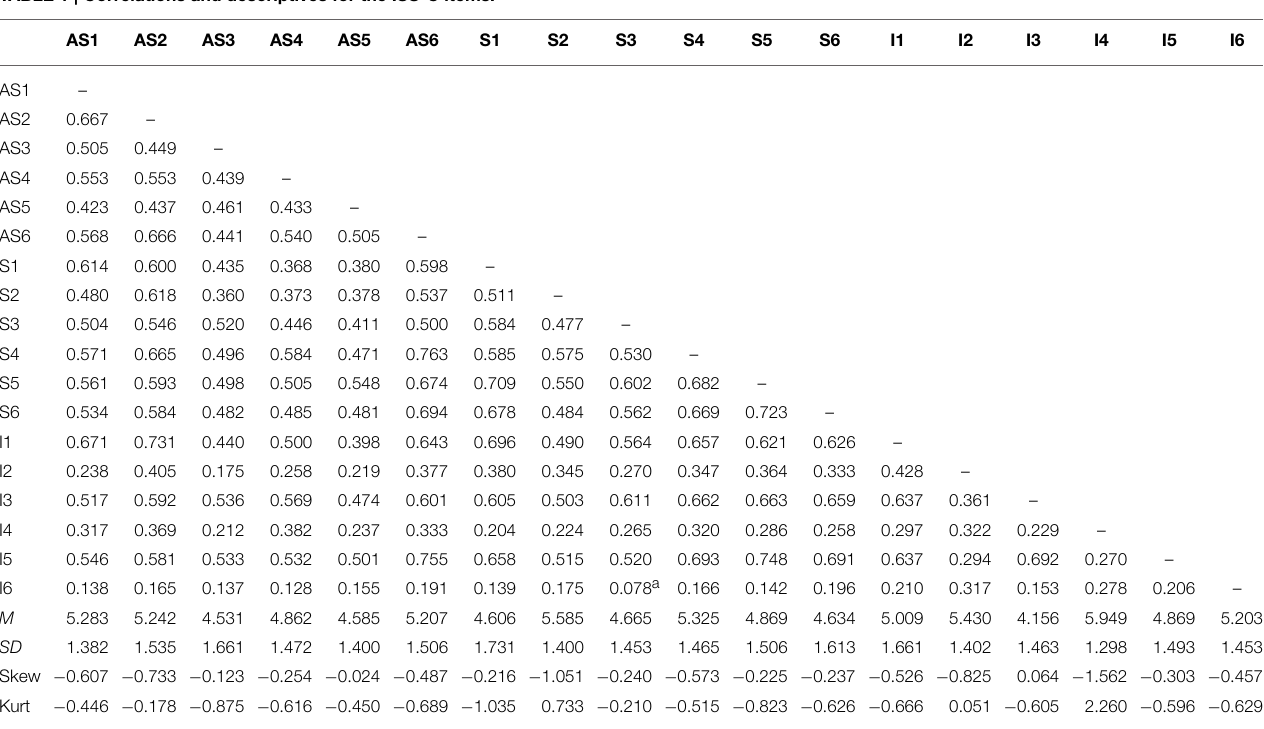
TABLE 1 | Correlations and descriptives for the ISS-C